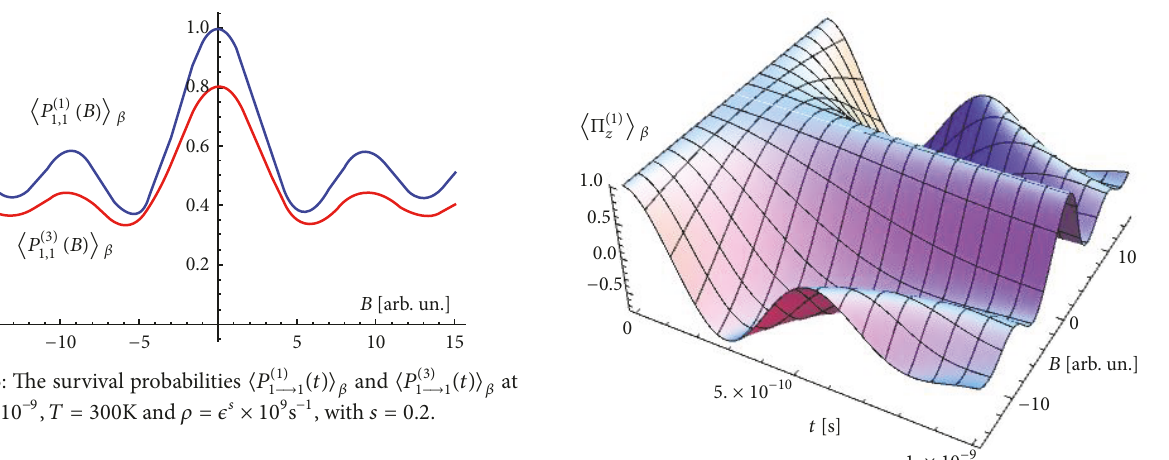
𝜌 (𝜀) = 10 9 𝜖 𝑠 , with 𝑠 = 0.2 . The oscillating behavior 𝜐